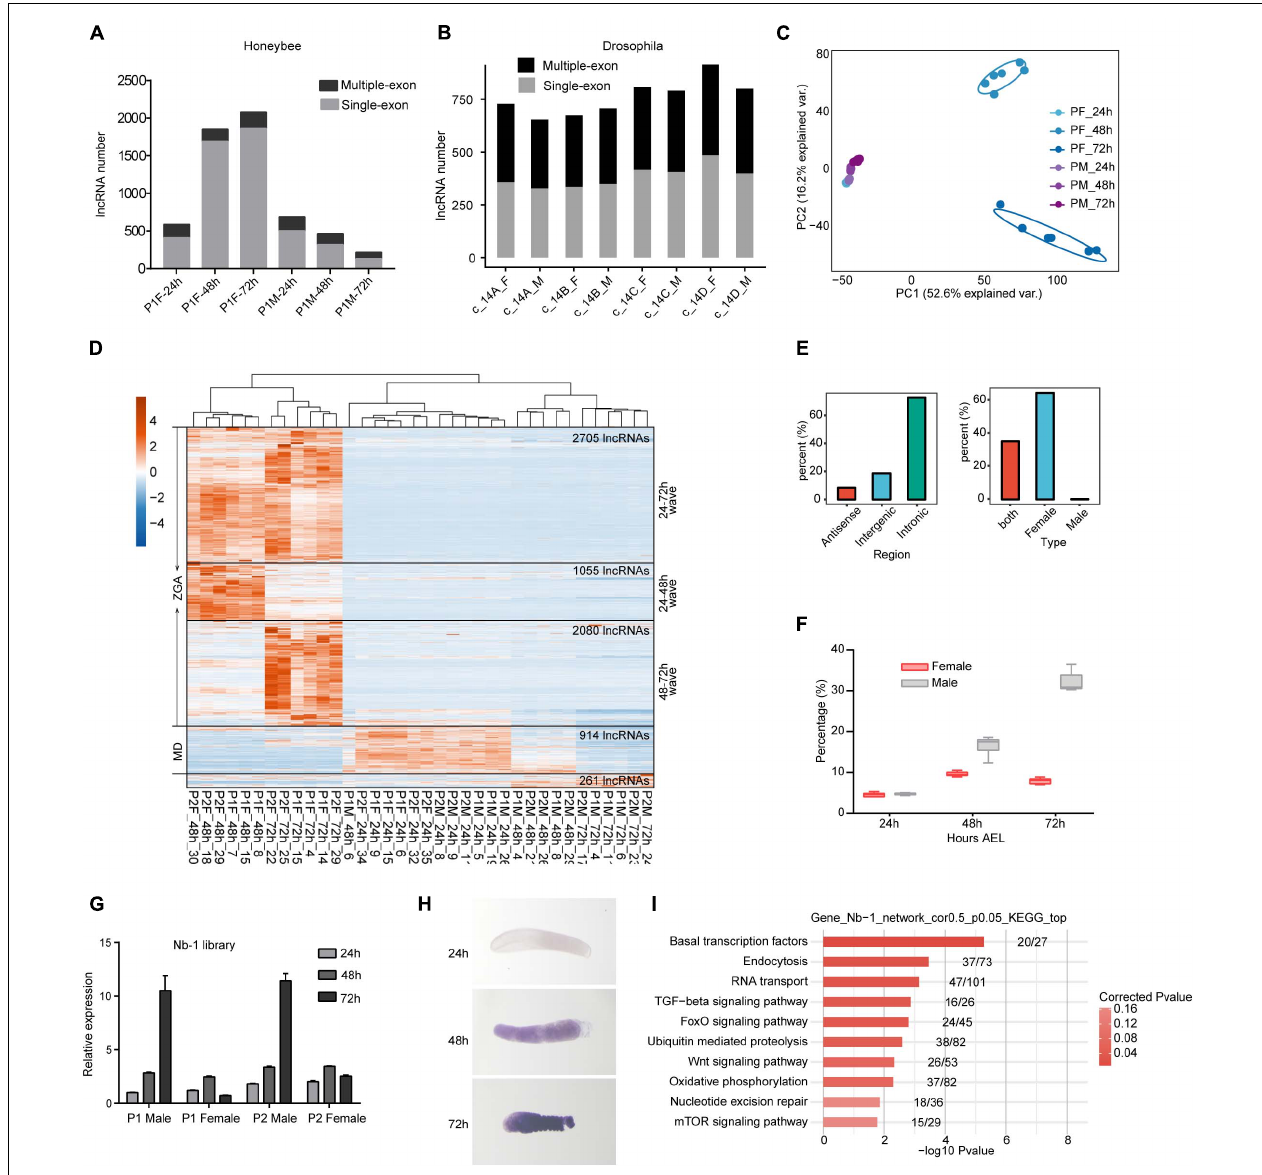
FIGURE 3 | LncRNAs are extensively activated during the embryonic development of honeybee female embryos. (A) The numbers of detected lncRNAs (1,000-nt threshold for single exon lncRNAs) were increased in female embryos, and decreased in male embryos. In each sample group, we randomly selected 20 million mapped reads from each sample to perform lncRNAs prediction pipeline. Results of 18 samples from one queen were shown. The results of other 18 samples were similar. (B) The numbers of detected lncRNAs were not obviously changed in female and male embryos of fruit fly. The same analysis method was executed as in panel (A). (C) PCA analysis showing the divergent lncRNA expression pattern specifically for female embryos after 24 h (1,000-nt threshold for single exon lncRNAs). (D) Hierarchical clustering heatmap showing the zygotic expression waves of lncRNAs in female embryos (1,000-nt threshold for single exon lncRNAs). (E) The percentage of intronic lncRNAs (left) and female specific lncRNAs (right) among the zygotic activated lncRNAs shown in panel (D) . (F) Boxplot showing the increased percentage of Nb-1 reads relative to the total reads aligned to gene regions in honeybee female and male embryos. (G) RT-qPCR validation of Nb-1 expression showing high consistence with the sequenced libraries. (H) In situ hybridization experiment validated the robust increase of Nb-1 expression in male embryos. (I) Bar plot showing the top ten enriched KEGG pathways for genes whose expressions were correlated with Nb-1 ( p -value < 0.05 and PCCs >